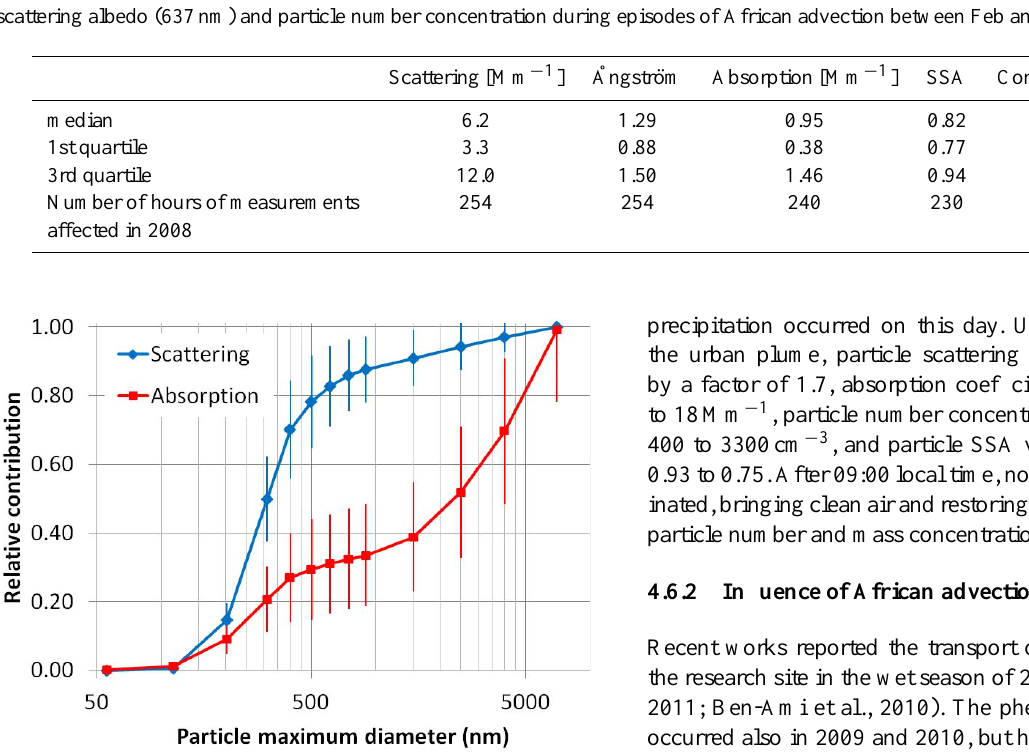
Fig. 13. Cumulative contribution of 13 particle size ranges to scat- tering (550nm) and absorption (637nm) coefficients calculated us- ing a Mie model. Error bars represent standard